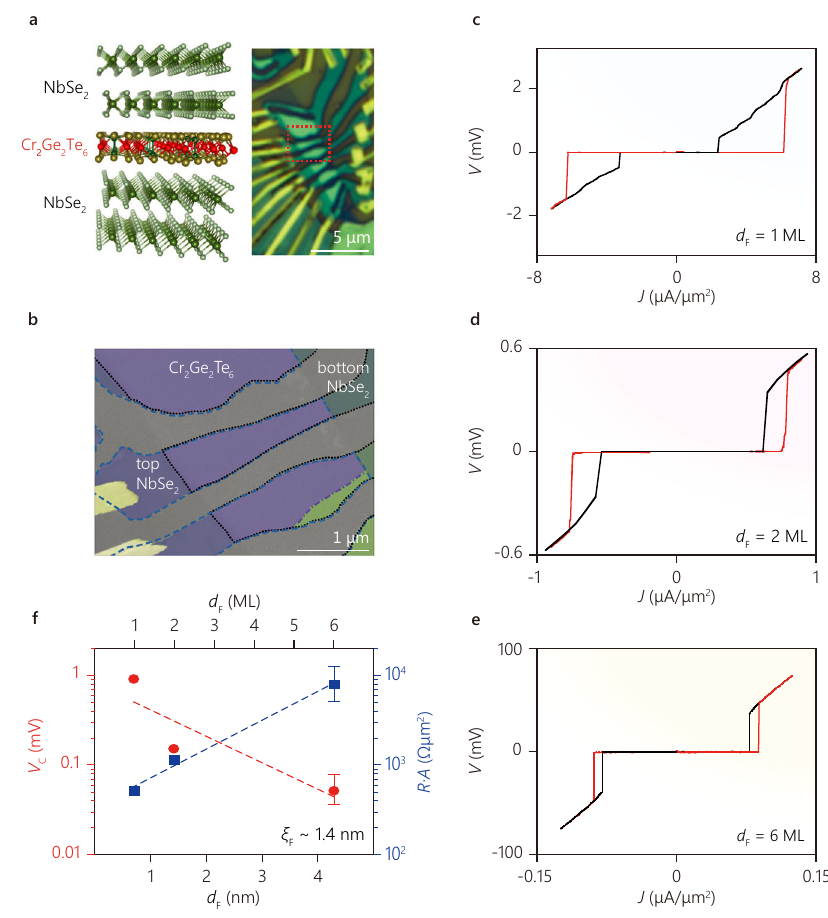
Fig. 1 Josephson coupling of the NbSe 2 /Cr 2 Ge 2 Te 6 /NbSe 2 van der Waals junction. a , b Schematic (left panel of ( a ) 16 ), optical micrograph (right panel of ( a )), and false color scanning electron microscope (SEM) image ( b ) of NbSe 2 /Cr 2 Ge 2 Te 6 /NbSe 2 Josephson junctions (JJs). In the schematic, top and bottom pairs of layers represent NbSe 2 and the middle layer represents Cr 2 Ge 2 Te 6 . In the optical micrograph, the gold contact leads appear as yellow lines and the JJ appears in green. The red dotted line indicates the area of the SEM image. In the SEM image, the areas of the top and bottom NbSe 2 fl akes are indicated by the blue dashed line and the black dotted line, respectively. The Cr 2 Ge 2 Te 6 and NbSe 2 layers are indicated by purple and green. The dash-dot line indicates the boundary of Cr 2 Ge 2 Te 6 . c – e V – J characteristics of the JJs for the Cr 2 Ge 2 Te 6 barrier thicknesses of 1, 2, and 6 ML. The junction area A is ~0.9 μ m 2 , ~4 μ m 2 , and ~1.4 μ m 2 , respectively. The red lines depict the transition from the superconducting state to the normal state whereas the black ones depict the transition from the normal state to the superconducting state. f The characteristic voltage (switching current normal resistance product, red dot) and resistance-area product (blue rectangle) of the junction with different barrier thickness. The thickness of the barrier is shown in units of both nanometers and the number of layers (ML). Fitted result is shown in dashed lines and error bars indicate standard